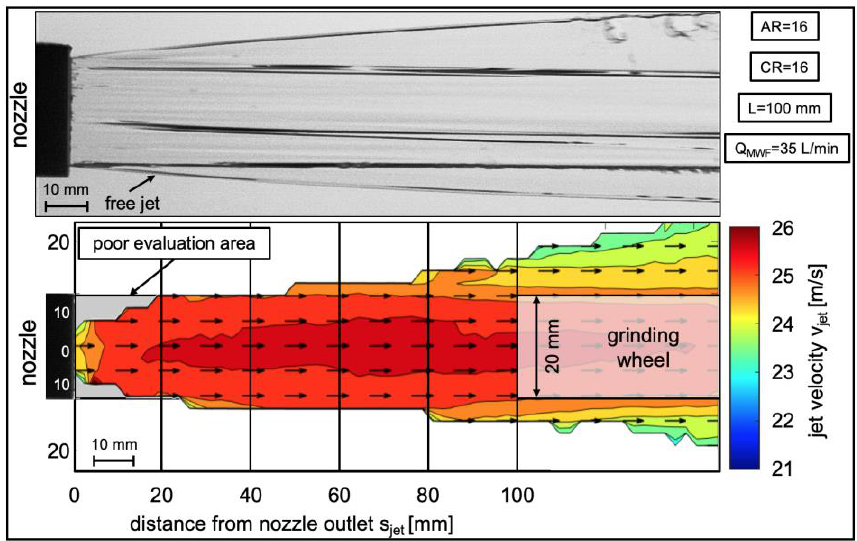
Figure 9. Exemplary results of the shadowgraphy and the associated SIV-derived velocity field. Free jet expansion occurs with increasing distance s jet . Due to the free jet expansion and the interaction of the free jet with the ambient air, the velocities at the free jet edge are lower than in the free jet’s core. For the following evaluation of the mean velocity in the free jet, a free jet width of 20 mm is referred to, since a grinding wheel with a width of 20